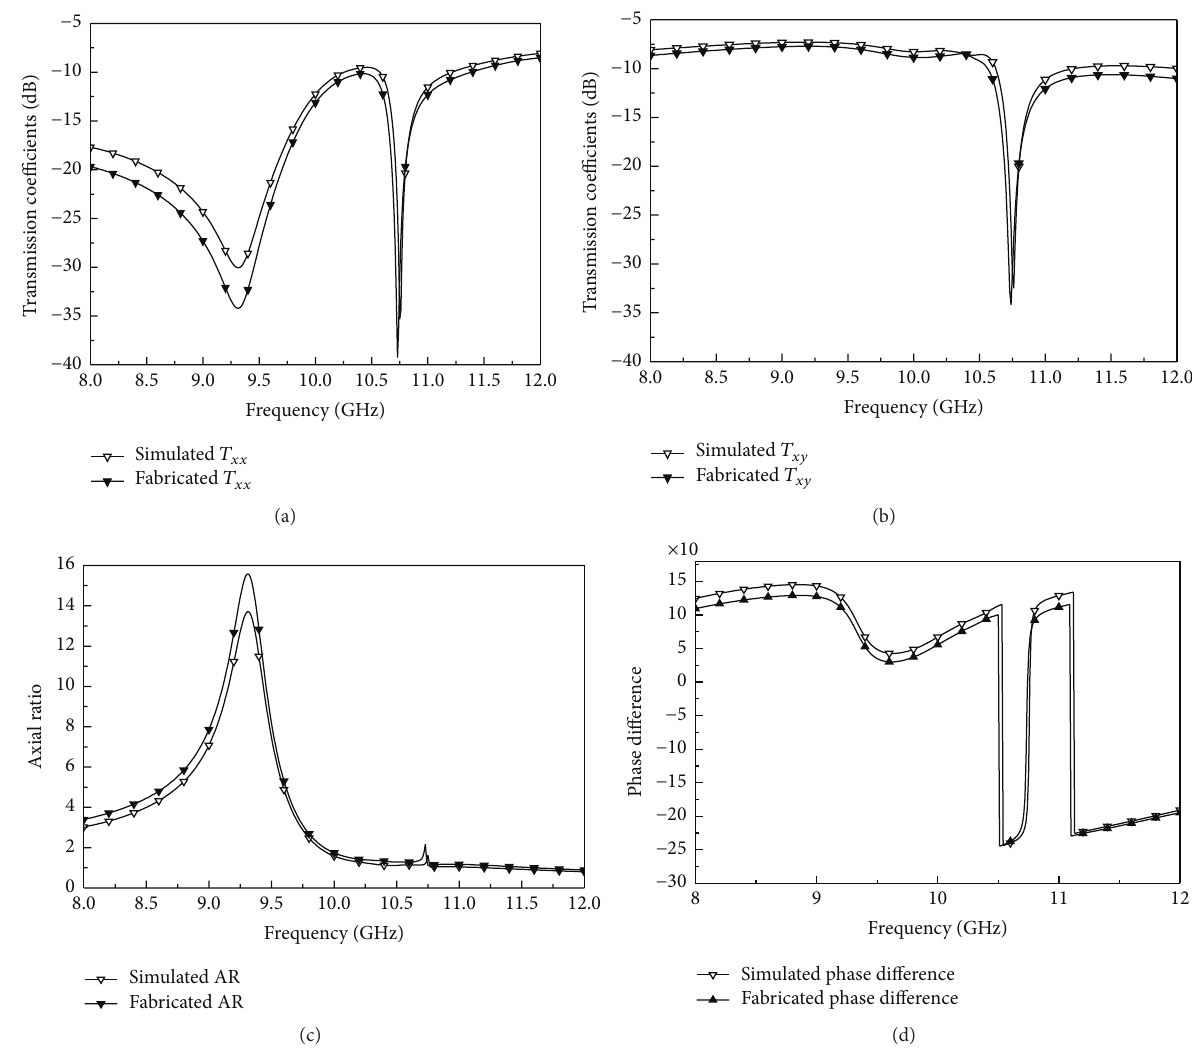
Figure 6: The figure shows the simulation and experimental results for multiband circular polarizer. (a) represents the transmission coefficients of 𝑇 𝑥𝑥 versus frequency for normal incident wave at 𝜃 = 0 ∘ , (b) indicates the transmission coefficients of 𝑇 𝑥𝑦 versus frequency for normal incident wave at 𝜃 = 0 ∘ , (c) shows the axial ratio versus frequency, and (d) shows the phase difference between transmitted waves versus frequency of designed